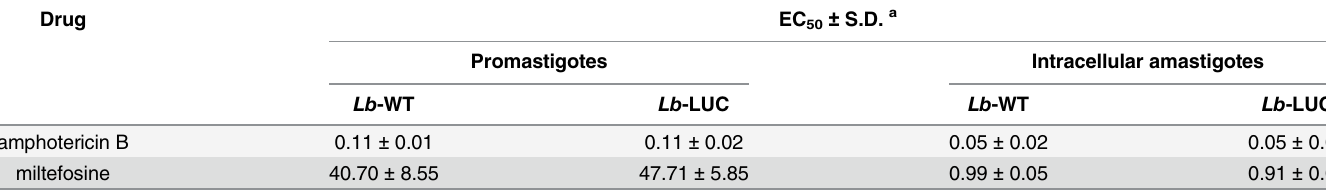
Table 1. Drug susceptibility in promastigotes and intracellular amastigotes of the wild type and the transgenic line of L . braziliensis H3227.